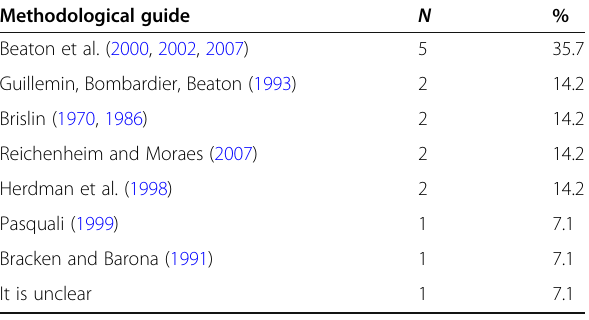
Table 2 Methodological guidelines used in the studies included in this systematic review Methodological guide